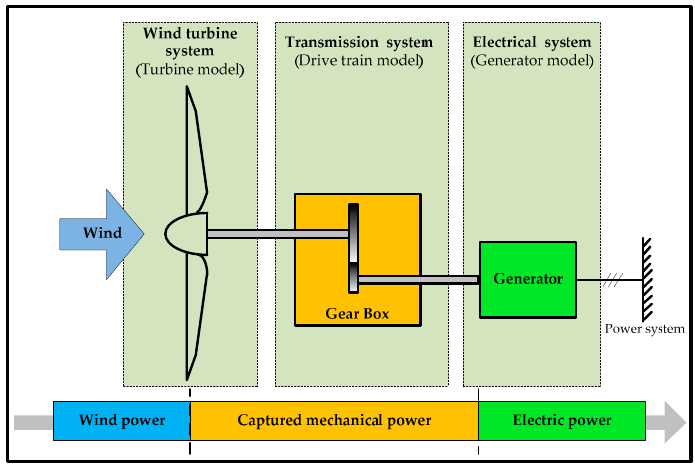
Figure 1. Overall schematic of a wind energy conversion system.